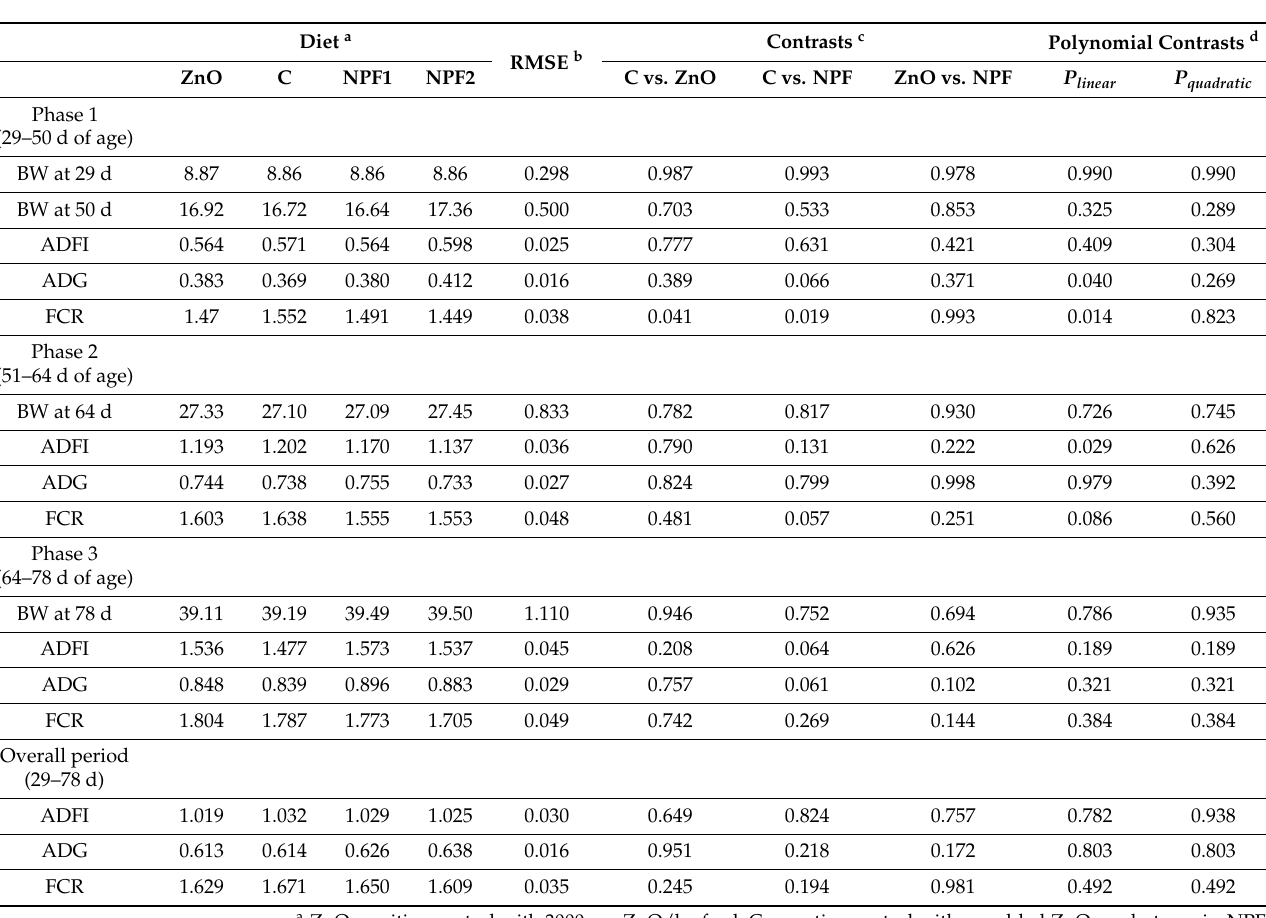
Table 4. Effect of diet on body weight (BW, kg/piglet), average daily feed intake (ADFI, kg/piglet/day), average daily weight gain (ADG, kg/piglet/day) and feed conversion ratio (FCR, kg feed/kg gain) during the